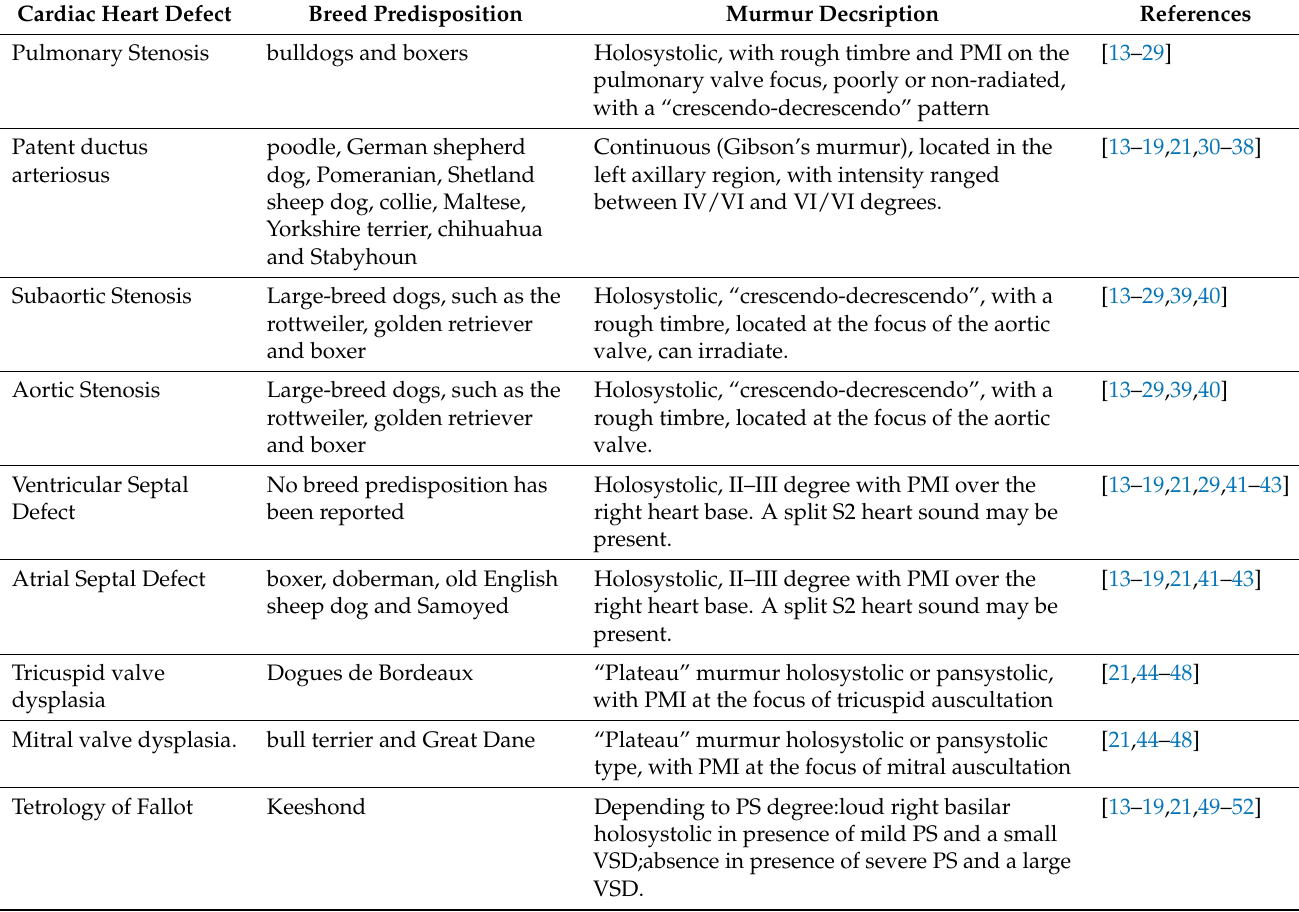
Table 2. Breed predisposition and murmur description of most common canine CHDs. Cardiac Heart